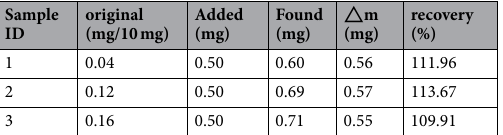
Table 2. Recovery test for saffron in Ershiwuwei Shanhu Wan. Note: Recovery [%] = 100 × (amount found- original amount)/amount added; RSD [%] = 100 ×